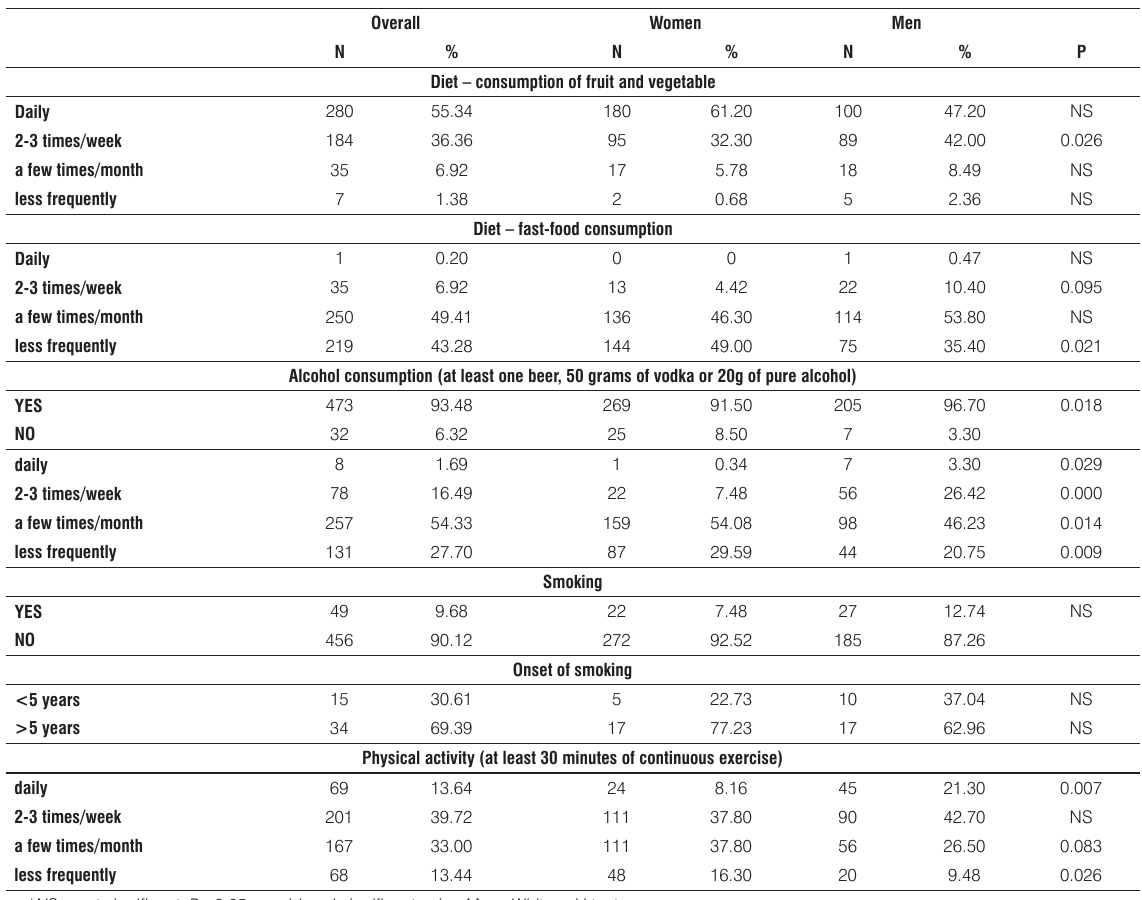
Table 2. Overall results of the StudHeart study research.